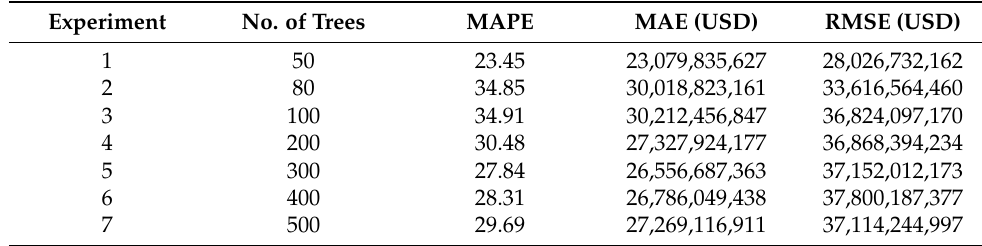
Table 1. Revenue loss prediction errors due to hurricanes.